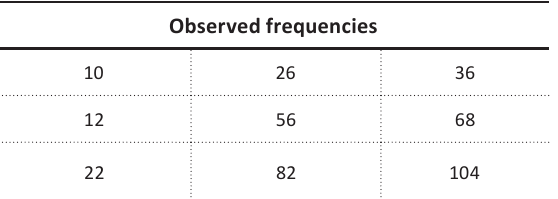
Source: Own survey.